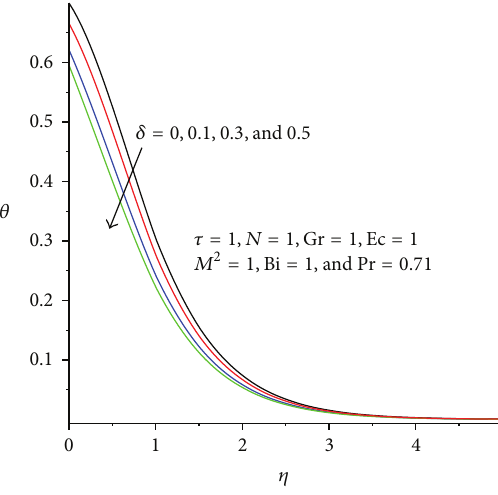
Figure 17: Temperature profiles with increasing 𝛿 .